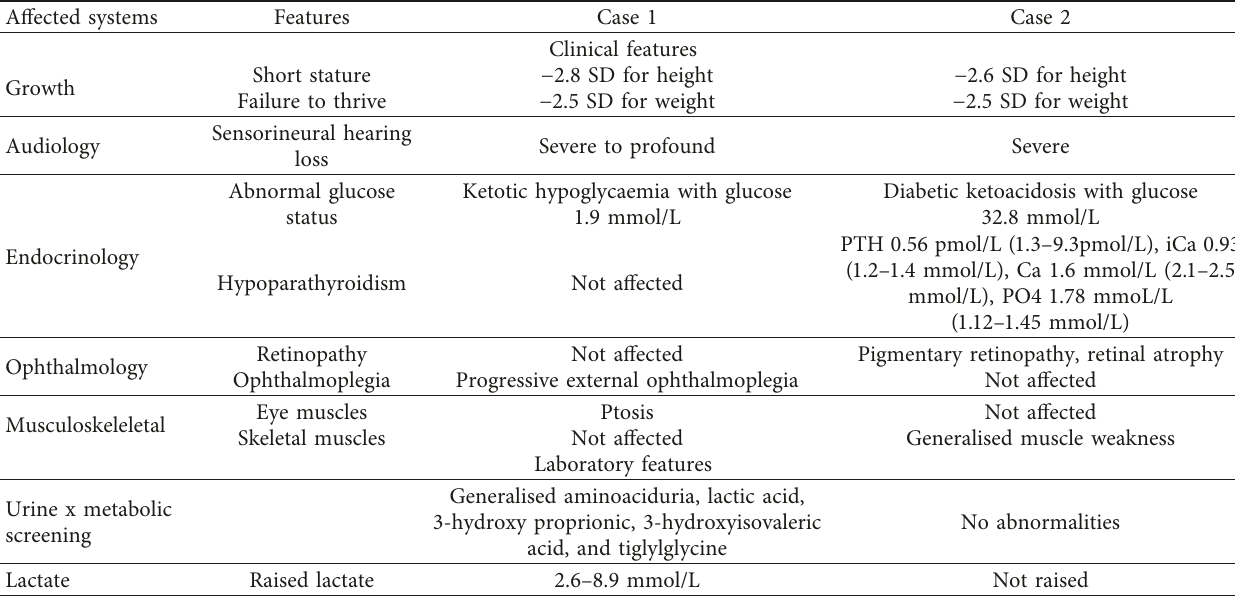
Figure 6: DNA sequencing electrophoretogram demonstrating the breakpoint. Blue arrows from the top indicate the nucleotides on the two sides of the breakpoint (m.8648 and m.16085). Another blue arrow from the bottom indicates the nucleotide m.8649 in the wild type. Table 1: Clinical and laboratory features of the two patients with Kearns–Sayre